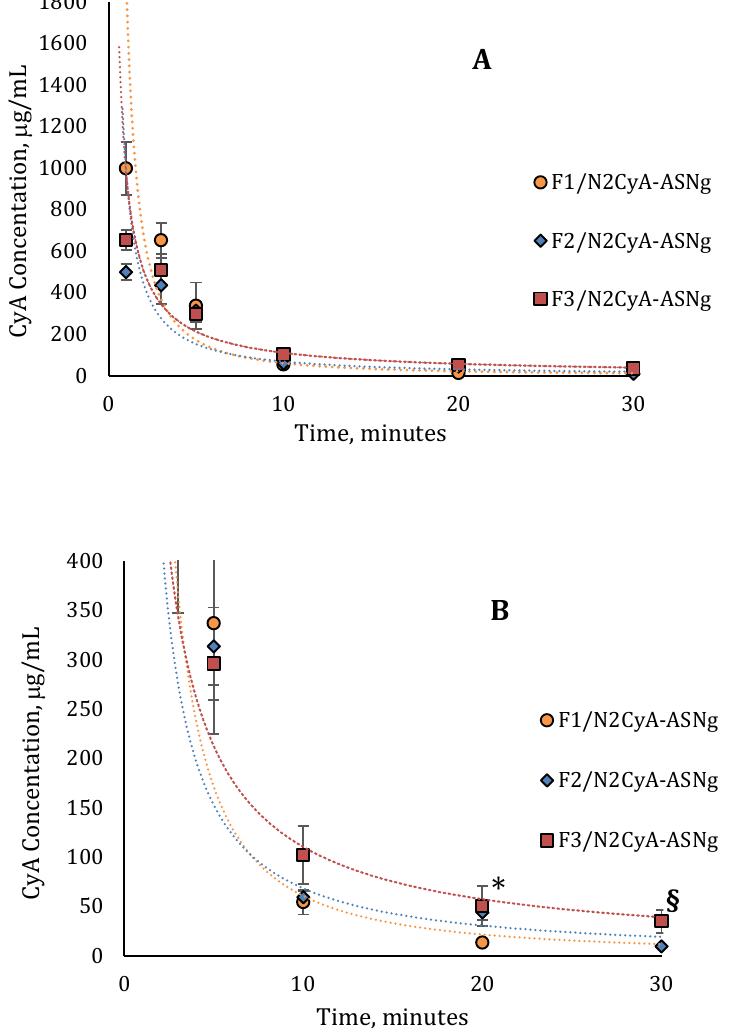
Figure 9 - In vivo pharmacokinetics profile of (A) nanomicellar fomulations with different 950 Figure 9. In vivo pharmacokinetics profile of ( A ) nanomicellar fomulations with different concentra- concentration of GG-LA (n=6, Mean ± SE); (B) Magnification of pharmacokinetics profile from 0 951 tions of GG-LA ( n = 6, mean ± SE); ( B ) magnification of pharmacokinetics profile from 0 to 400 µ g/mL. * Statistically different from F1/N2CyA-ASNg; § statistically different from F2/N2CyA-ASNg. to 400  g/mL. Table 9. In vivo pharmacokinetics parameters of CyA in rabbit tear fluid (mean ± SE, n = 6).